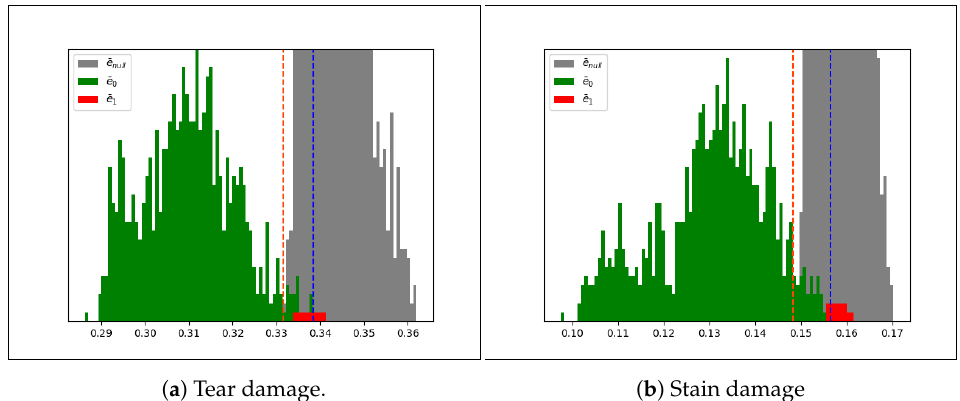
Figure 10. Accuracy variability of different percentiles on tear ( a ) and stain ( b ) damages. For both the plots x -axis represents the values of the distances obtained and y -axis the number of occurrences. ¯ e null , ¯ e 0 and ¯ e 1 are represented by gray, green and red respectively. Table 7. Percentage of uncertainty zone ( z ) and percentage of ¯ e 0 inside it ( r ) for each analyzed